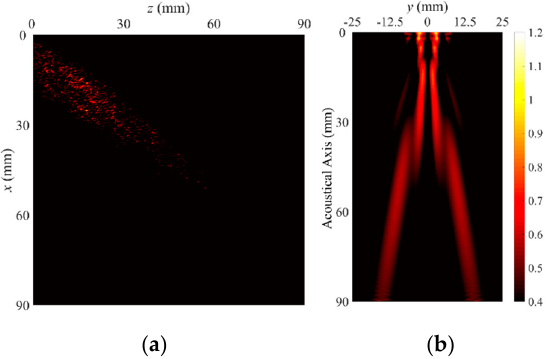
Figure 7. Radiation patterns and beam profiles of leaky A(0,2) mode Lamb wave, ( a ) vertical beam profile, and ( b ) lateral beam profile.